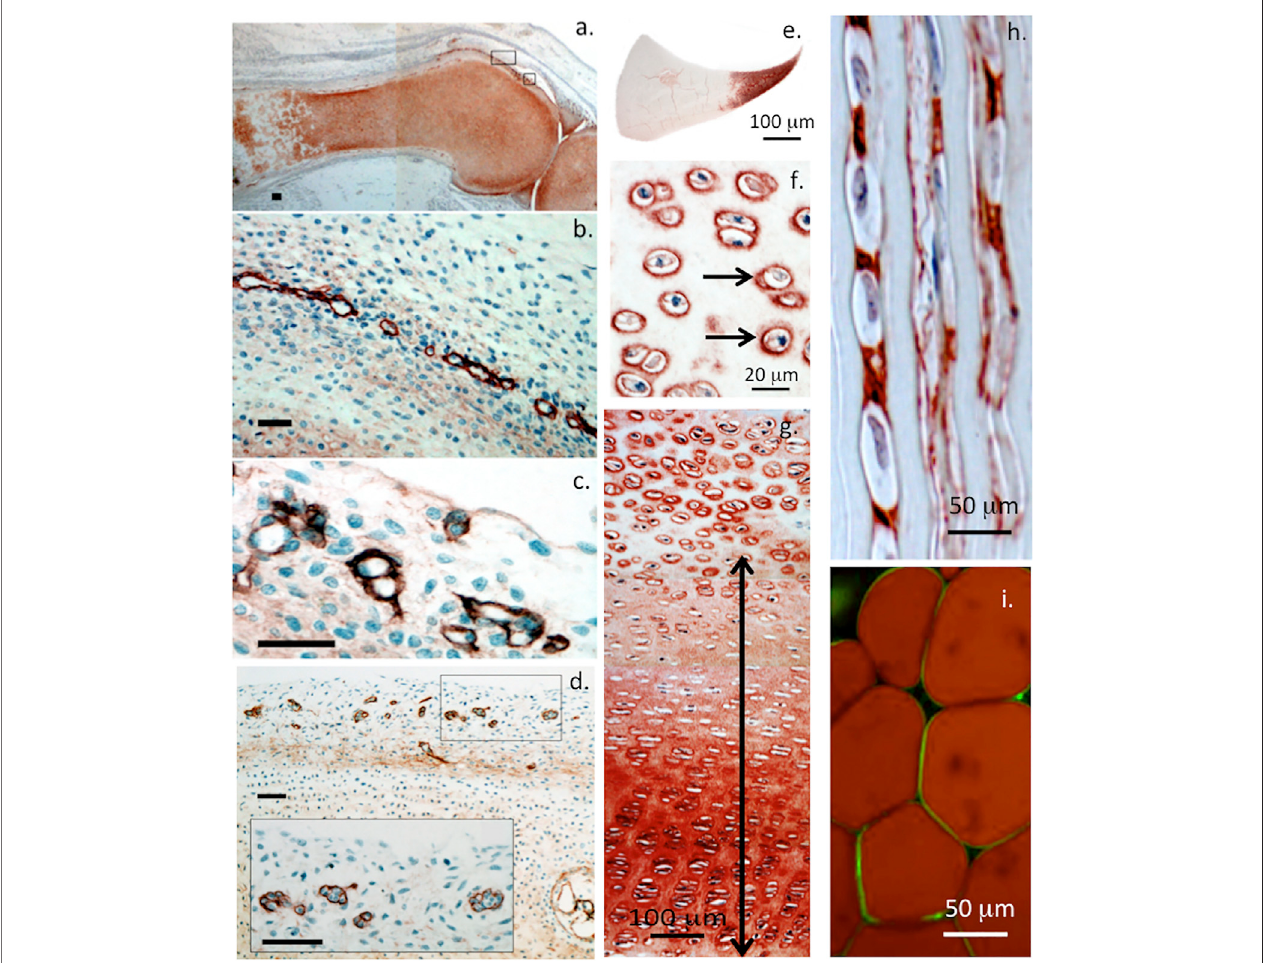
FIGURE 2 | Immunolocalisation of perlecan in 14-week-old human foetal knee joint (A – D) , newborn ovine cartilaginous tissues (E – H) and mature human adipocytes (I) . Perlecan has a diffuse distribution in cartilage rudiments in the femur and tibia of a foetal knee joint (A) . The boxed areas in (A) are depicted at higher magni fi cation in (B,C) . These show strong localization of perlecan in putative stem cell niches in the surface region of the cartilage rudiments (B,C) and diffuse extracellular staining in the rudiment. Perlecan localization in putative stem cell niches within the surface regions of a hip rudiment (D) . The boxed area in (D) is depicted at higher magni fi cation in the inset. Scale bars in (A – D) , 50 μ m. Macroscopic immunolocalisation of perlecan in a newborn ovine medial meniscus. Perlecan is concentrated predominantly within the inner cartilage-like meniscal zone (E) . Pericellular immunolocalisation (arrows) of perlecan within neonatal ovine femoral head articularcartilage (F) andrestingzonetibialgrowthplatechondrocytes.Doubleheadedarrowindicatesextracellulargradientofperlecanimmunolabelextendingfromthe restingzonethroughtothecolumnarproliferatingandhypertrophicgrowthplatechondrocytes (G) .Polarisedpericellularimmunolocalisationofperlecaninstringsofcells in the newborn ovine ACL (H) . Pericellular immunolocalization of perlecan around human adipocytes (I) . (A – D) modi fi ed from (Melrose and Melrose, 2016) with permission, images © Melrose 2016, (E – H) modi fi ed from (Smith et al., 2010), (I) reproduced from (Yamashita et al., 2018) with permission.